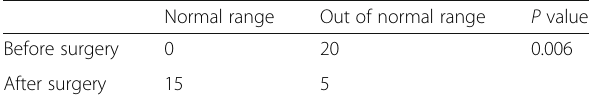
Table 1 Distribution of patients undergoing rhinoplasty in terms of nasolabial angle before and after surgery Normal range Out of normal range